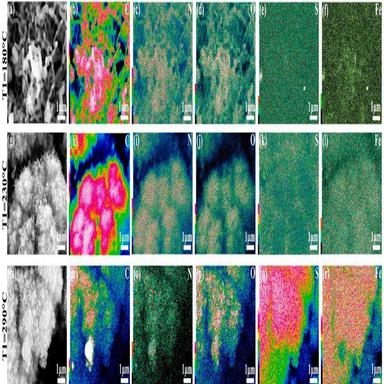
Cristina L. Rodríguez-Corvera et al. Energy-dispersive X-ray spectroscopy (EDS) elemental mapping obtained by FESEM. (a) SEM micrograph of secondary electrons, (b-f) elemental-mapping of C, N, O, S, and Fe for T1 = 180 ◦C. (g) SEM micrograph of secondary electrons, (h-l) elemental mapping of C, N, O, S, and Fe for T1 = 230 ◦C. (m) SEM image, (n-r) elemental-mapping of C, N, O, S, and Fe for T1 = 290 ◦C. The color scale on the left side of each frame points out the relative number of X-ray counts per pixel.